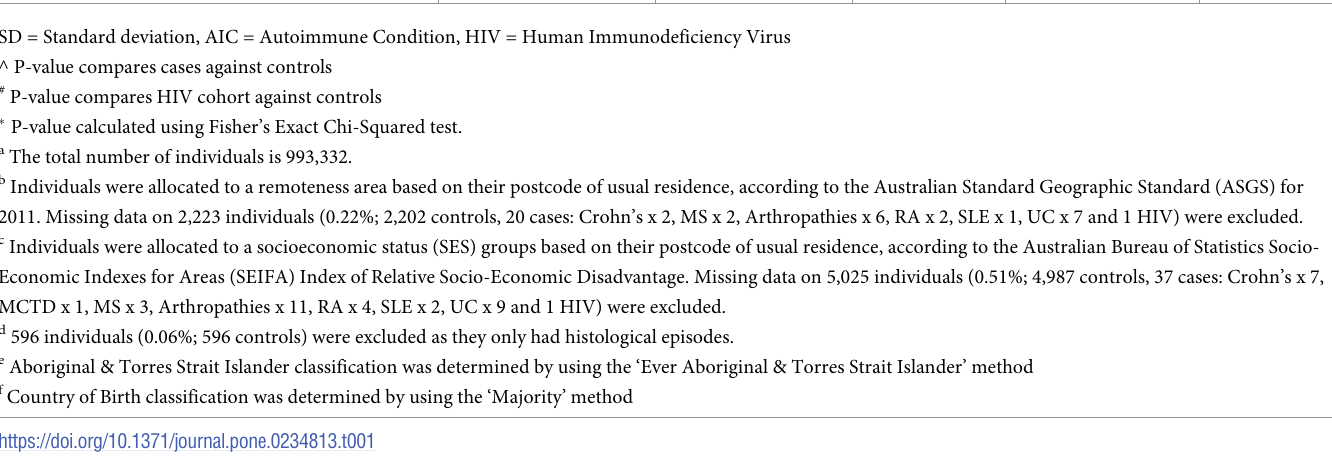
pared to controls (17.14 vs 19.99 per 1,000 person-years, AHR = 1.23, p = 0.008).